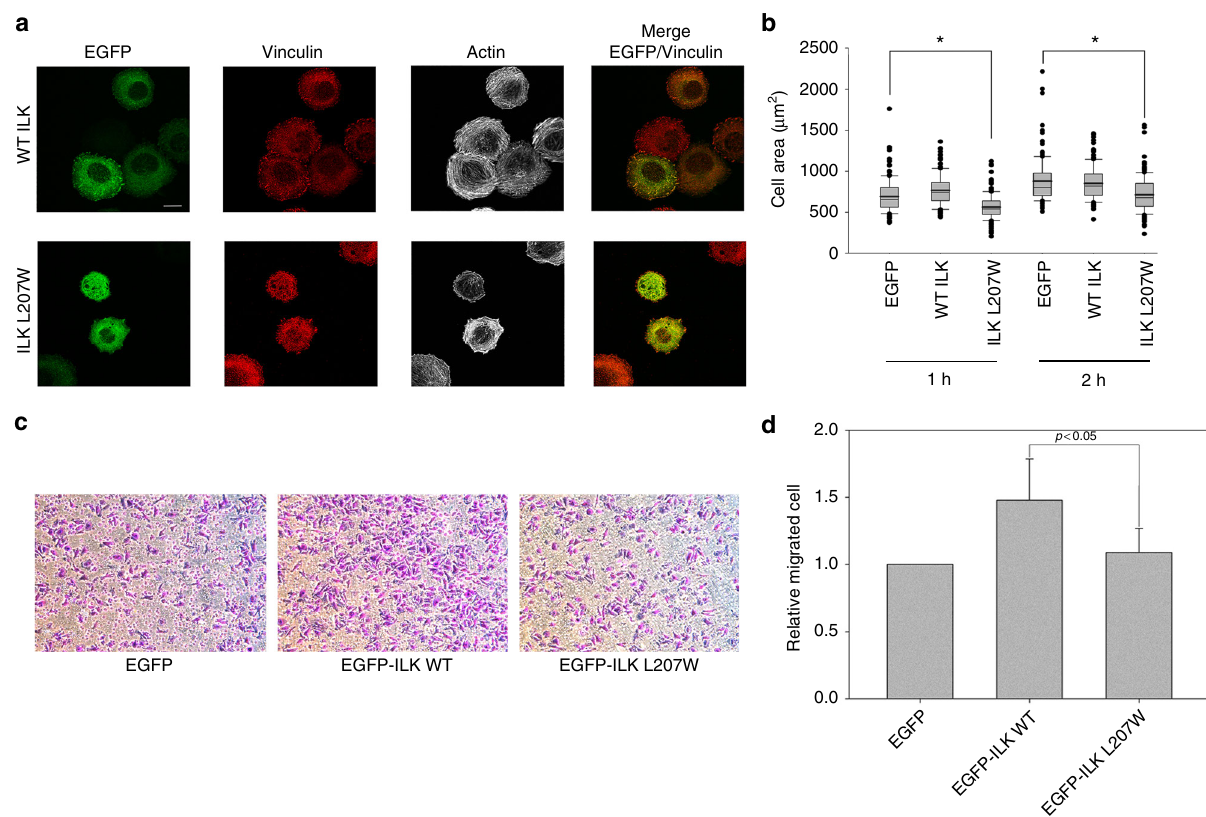
Fig. 7 Overexpression of ILK L207W causes defects in cell spreading and migration. a HEL cells expressing EGFP-ILK WT or EGFP-ILK L207W were stimulated with 800 nM PMA for 10 min, spread on 20 μ g ml − 1 fi brinogen for 1 h, fi xed and stained with Alexa 647-phalloidin to visualize actin and anti- vinculin antibodies to mark focal adhesions. Transfected cells were identi fi ed with EGFP fl uorescence. (Top panels) WT EGFP-ILK promotes formation of F- actin stress fi bers. By contrast, the stress fi bers were substantially disrupted in cells expressing the mutant ILK (bottom panels). Scale bar, 10 µ m. b Quantitative analysis of inhibition of cell spreading by ILK L207W as compared to the WT ILK. The areas of EGFP-positive cells were measured using ImageJ software. * P ≤ 0.001. In total, 150 cells were quanti fi ed in each sample. The box of the boxplot illustrated the upper and lower quartile for each population (EGFP vector, EGFP-ILK-WT and EGFP-ILK L207W). Median of spreading area is marked by a horizontal line within the box. The attached whisker indicates the range, and the discrete points ( (cid:129) ) are the outliers. c Overexpression of WT ILK but not the L207W mutant in HeLa cells promotes cell migration signi fi cantly. Images were captured after 10 h migration, under 10x magni fi cation. d Quantitative change of cell migration with WT ILK versus ILK L207W mutant. The relative fold change of migrated cells was calculated from average of fi ve randomly picked fi elds for each insert. The results were obtained from three independent experiments. Values are given as mean ±